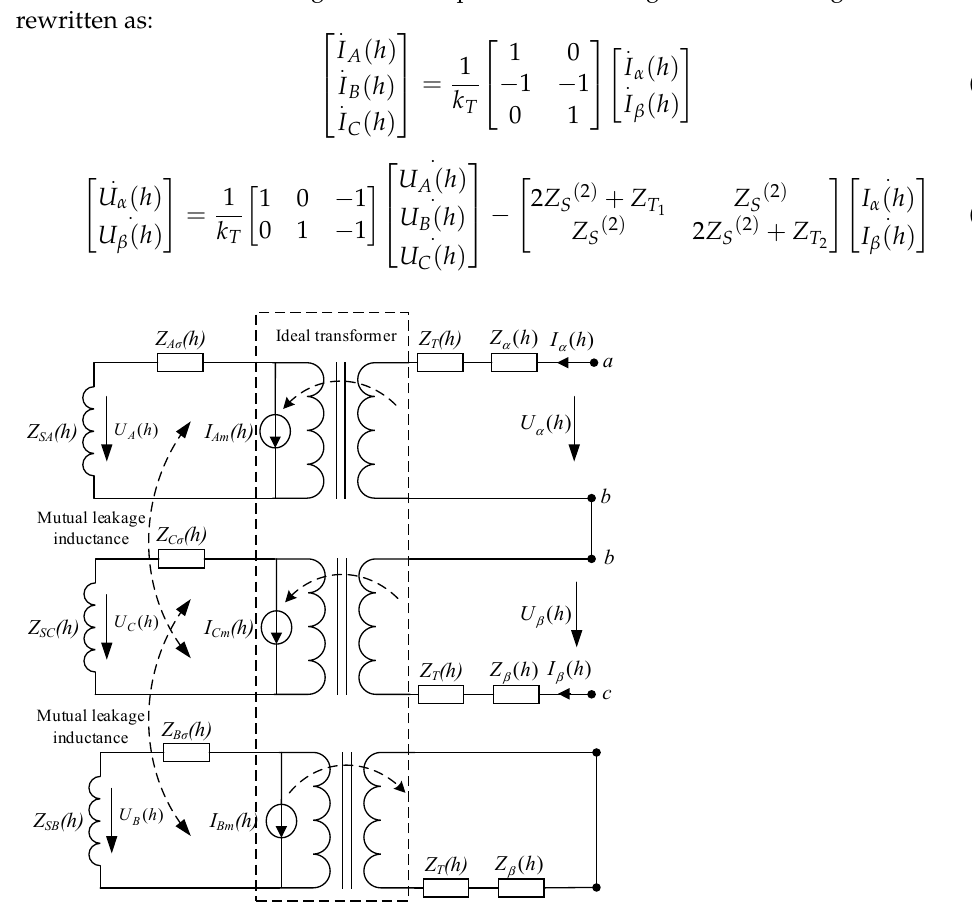
Figure 5. Harmonic propagation path on the high-voltage side of a V/v traction transformer. The low-voltage distribution system of the traction substation is supplied by the 27.5